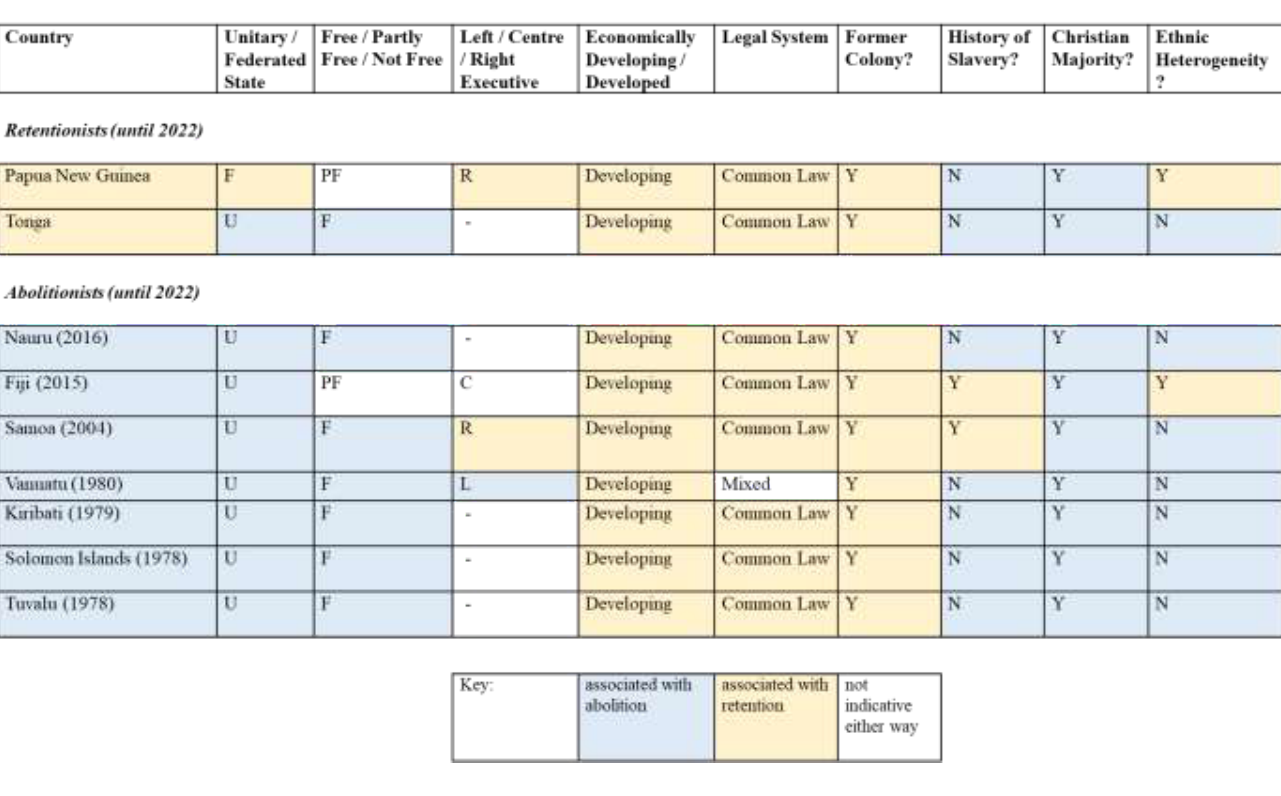
Table 3. South Pacific nations and the abolition/retention